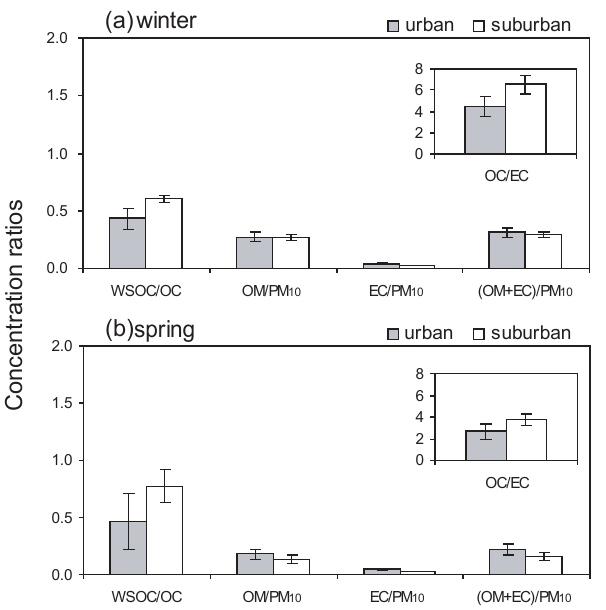
Fig. 2. Relative abundance of major species in the urban and subur- ban areas of Baoji City during winter and spring. Fig. 2 Relative abundance of major species in the urban and suburban areas of Baoji City during winter and spring